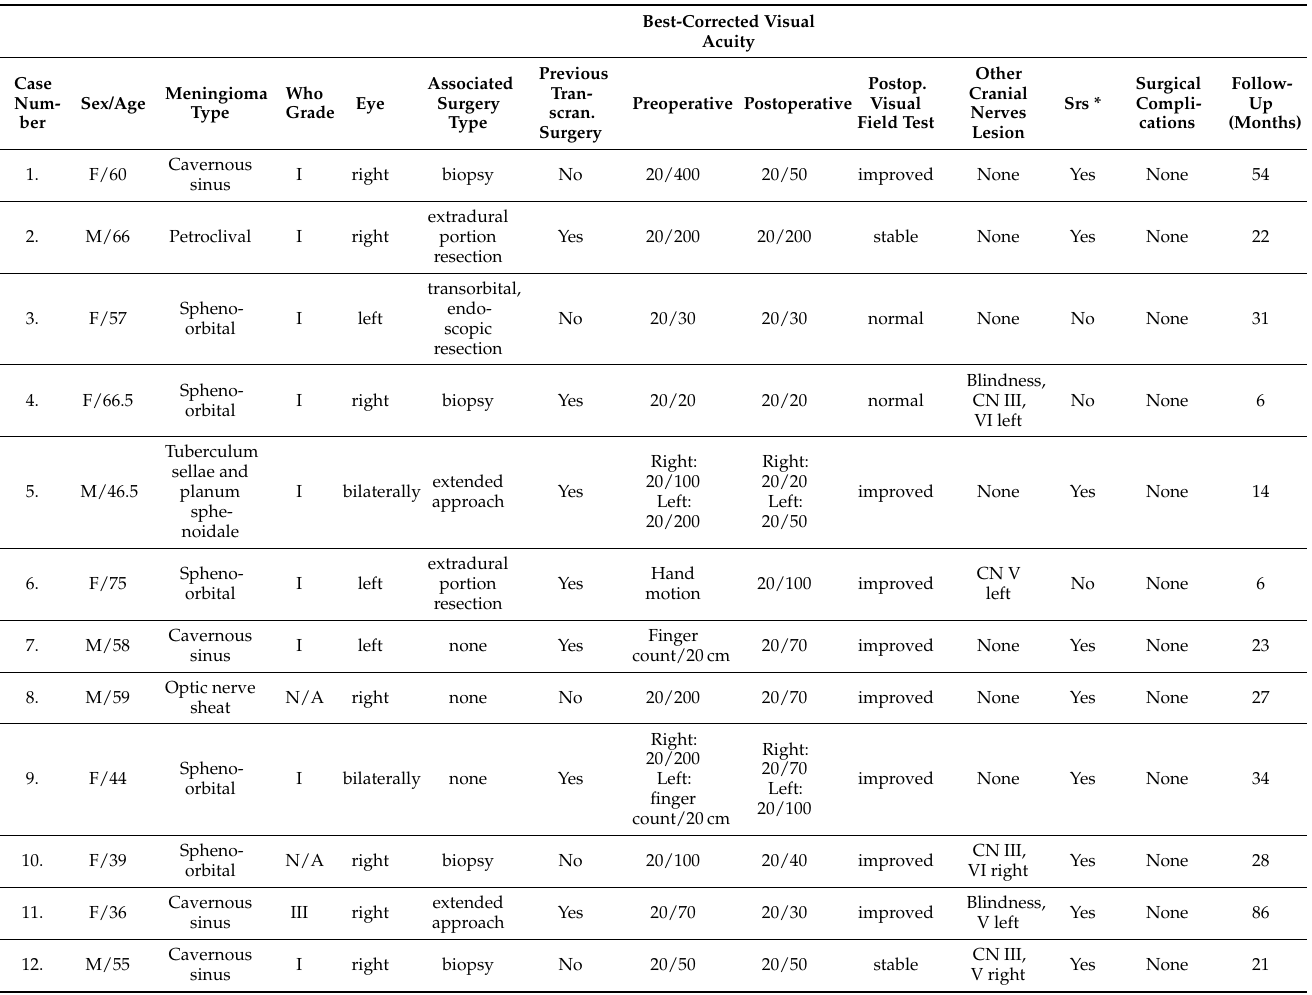
Table 1. Patient characteristics and visual